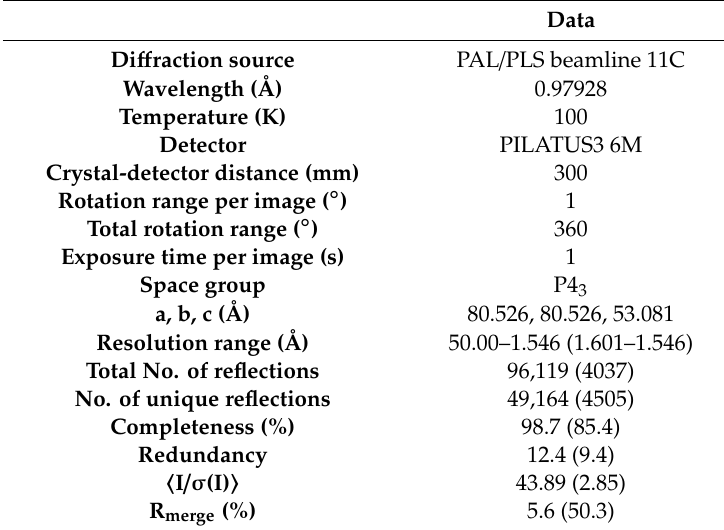
Table 2. Data collection and processing.